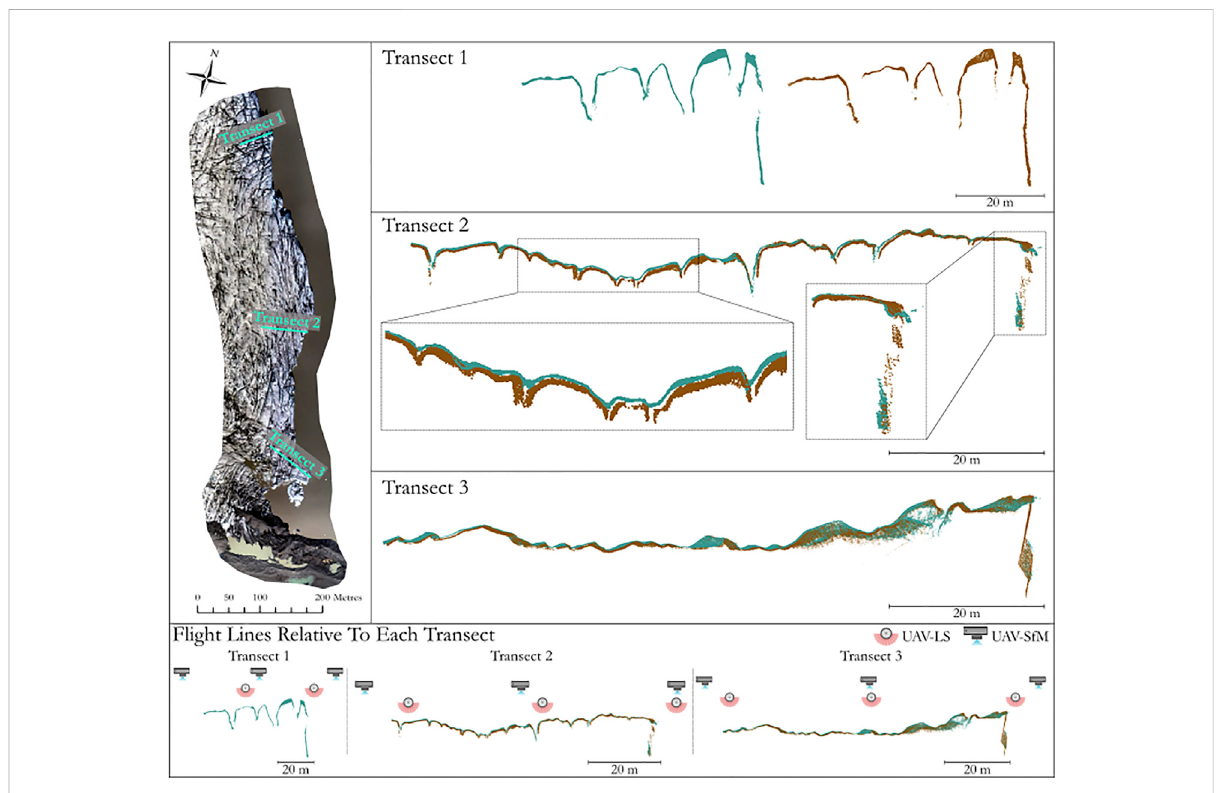
FIGURE 10 Transects across the glacier extracted from UAV-LS (brown) and UAV-SfM (blue) point clouds for the 9th July. Each transect compromises a different region of the glacier characterised by different crevasse morphologies. The location of each transect on the glacier surface can be seen in the left panel. The lower panel shows the fl ight paths above each of the transects (not to scale) to illustrate the position of both sensors mid-survey relative to the crevasse network, indicating good consistency between sensor locations across each